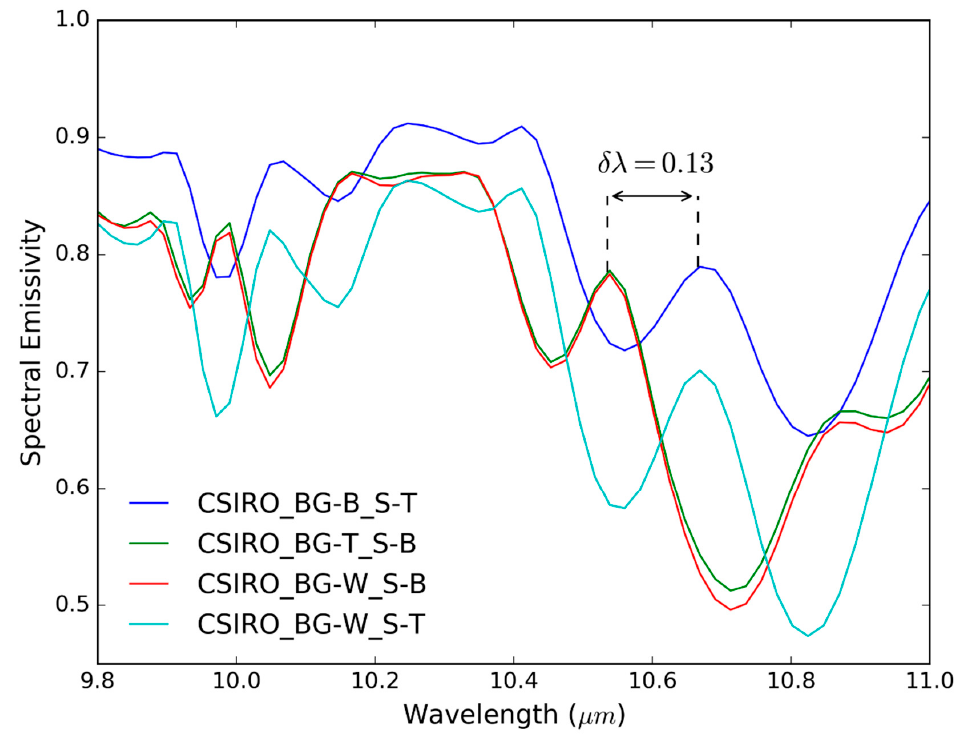
Figure 10. The CSIRO laboratory SE measurements of the specular reference sample (Sample 1) made using their Bruker VERTEX 80v FTIR spectrometer setup with the sample and reference in different positions, showing the wavelength shifts that appear in the 9.8–11 μ m spectral region. For legend abbreviations see Table 2.